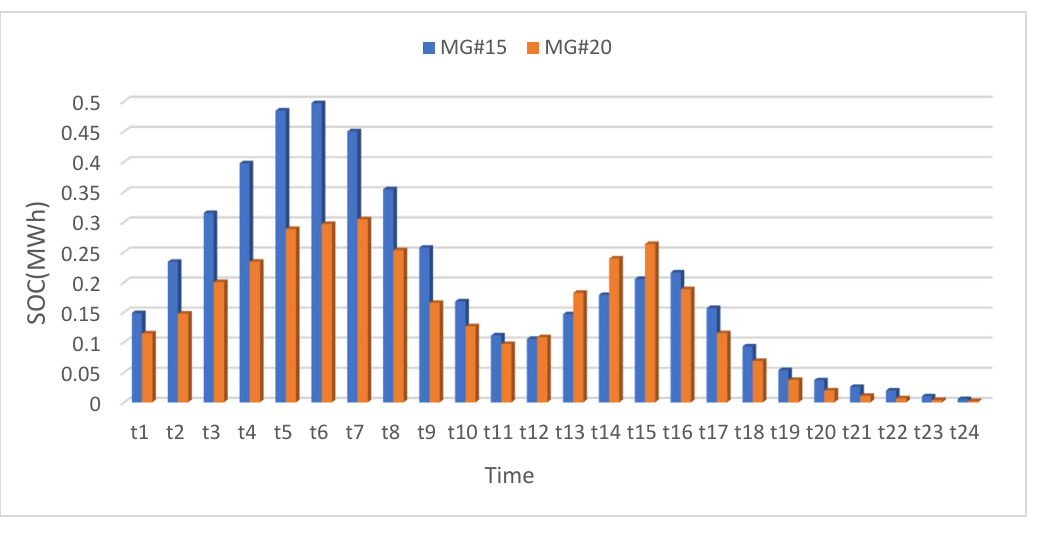
Figure 14. Power balance at each MG integrated with PEV − PLs.